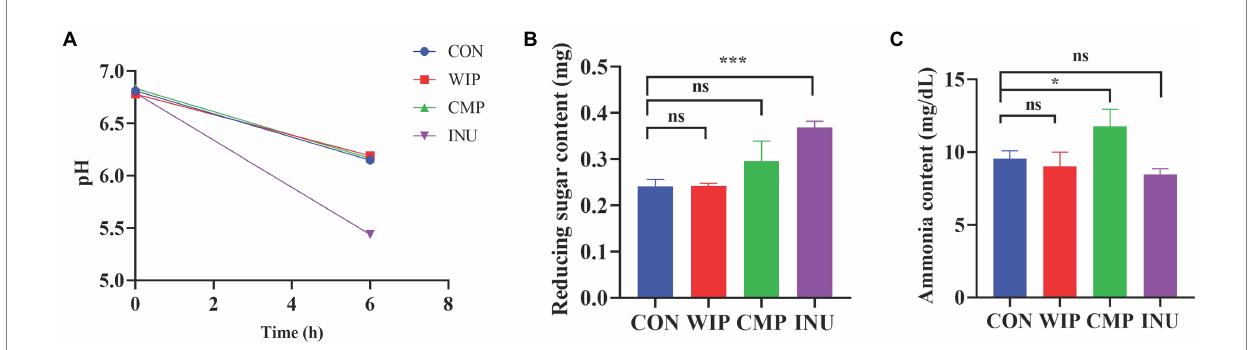
FIGURE 7 Effect of WIP, CMP and INU on (A) pH value, (B) reducing sugar content, and (C) ammonia content. * p < 0.05 and *** p <